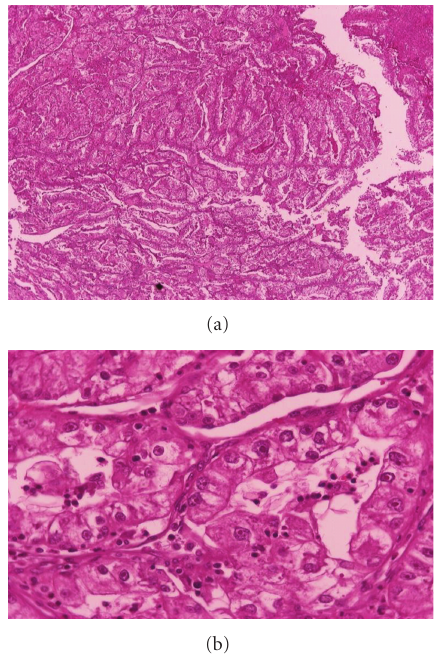
Figure 3: (a) Histology of the resected pancreatic specimen showing clear cells of renal cell carcinoma, capsule and normal pancreas. (b) Histology of the primary resected renal cell carcinoma showing the characteristic findings of large clear